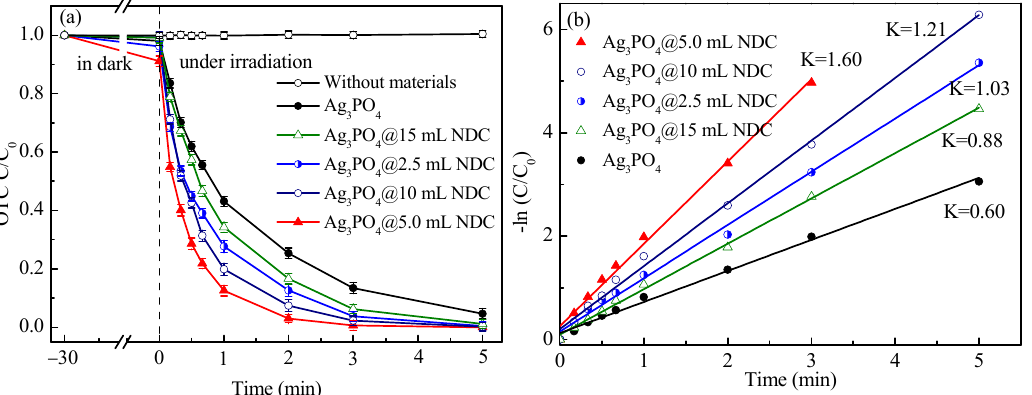
Figure 7. ( a ) Degradation curve of oxytetracycline by composite photocatalyst containing carbon materials with different proportions and silver phosphate monomer ([OTC]: 20 mg/L; catalysts: 50 mg; volume: 100 mL), ( b ) Pseudo first-order reaction kinetics curve fitted by degradation data.